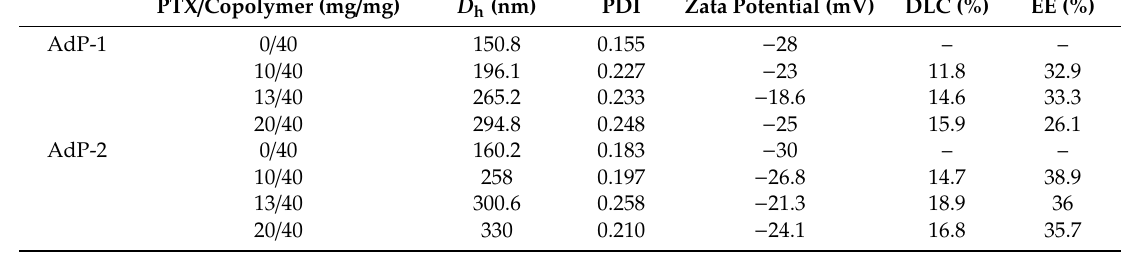
Table 2. The properties of blank and paclitaxel (PTX)-loaded micelles.